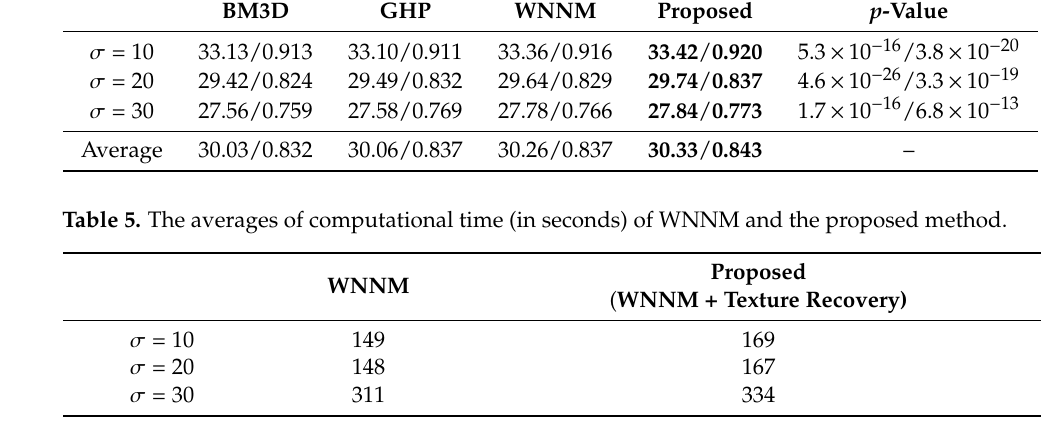
Table 4. The PSNR [dB] and SSIM results obtained after denoising on BSD100. The p -values were calculated by one-tailed paired t -tests on the difference of each PSNR and SSIM between the proposed method and WNNM. BM3D GHP WNNM Proposed p -Value